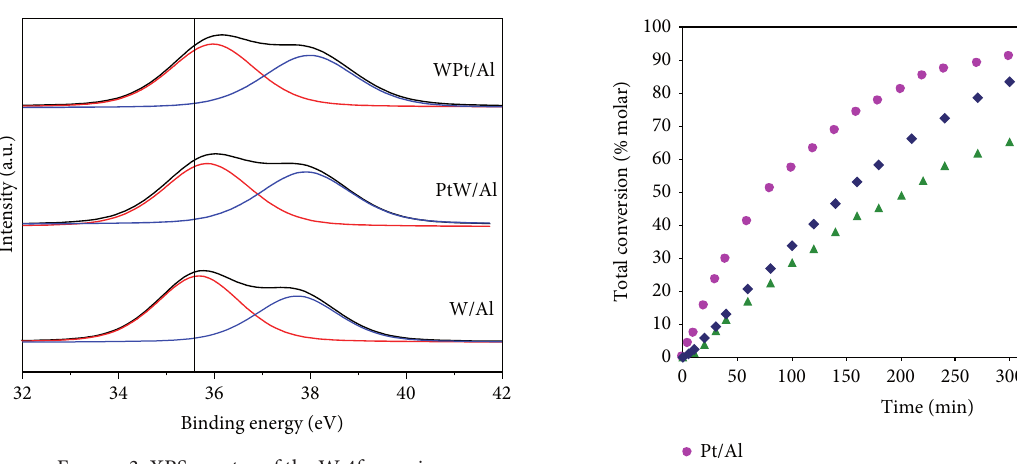
F 3: XPS spectra of the W 4f